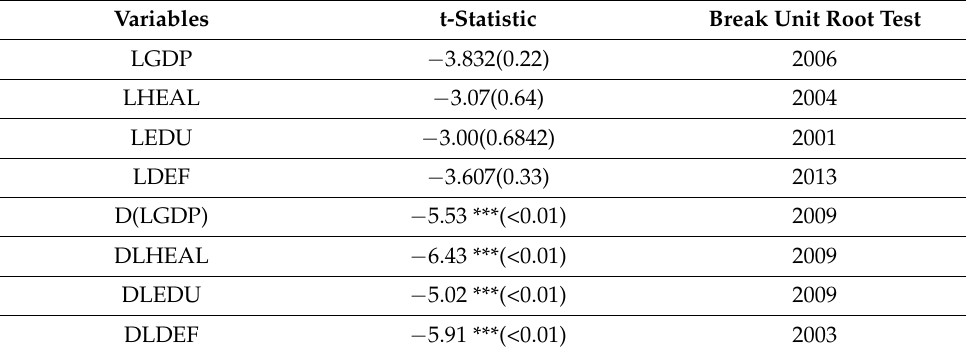
Table 2. Break Unit Root